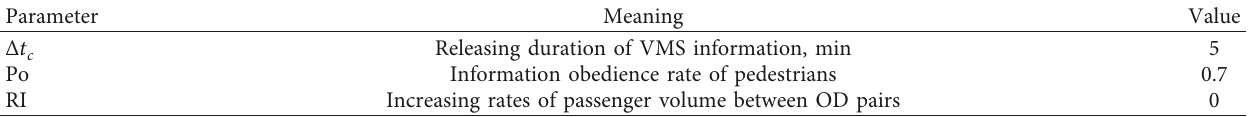
Table 1: Values of the key parameters of the scenario used for comparison.